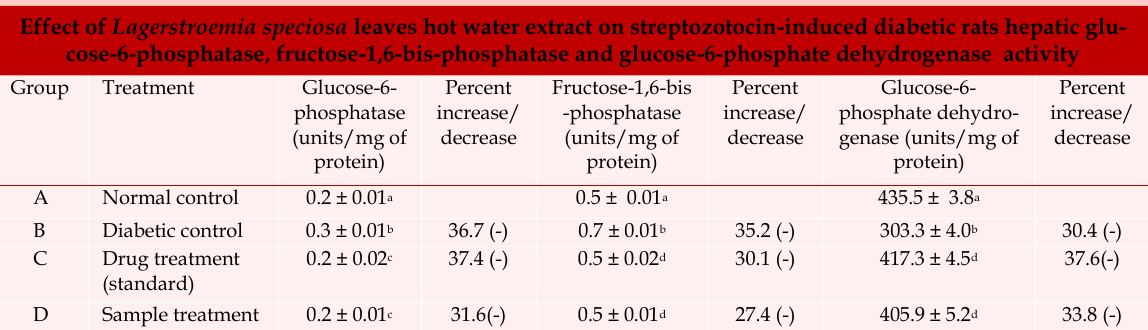
Effect of Lagerstroemia speciosa leaves hot water extract on streptozotocin-induced diabetic rats hepatic